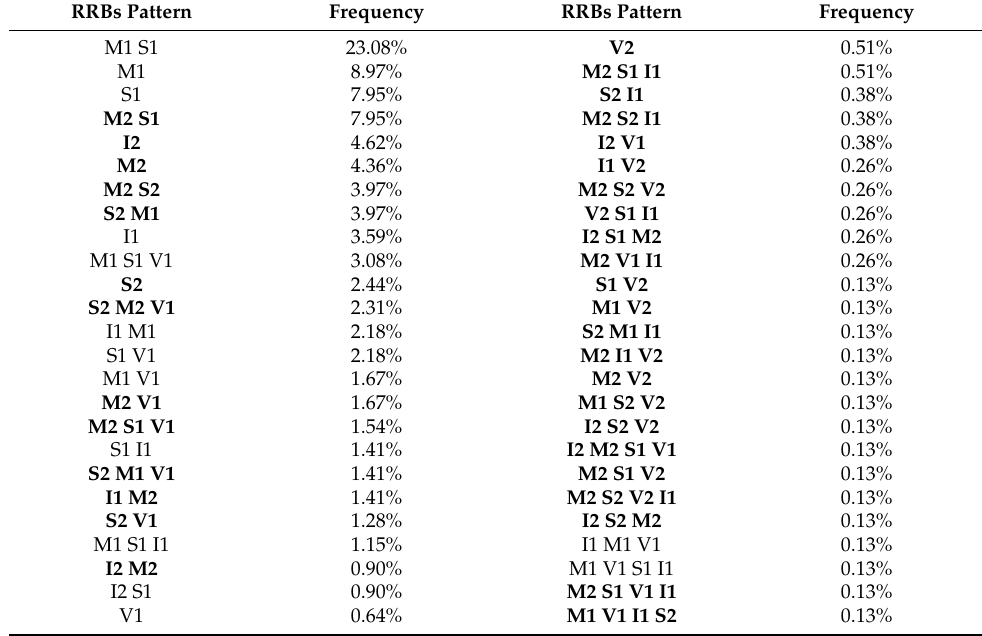
Table 2. Distribution of RRBs patterns of the